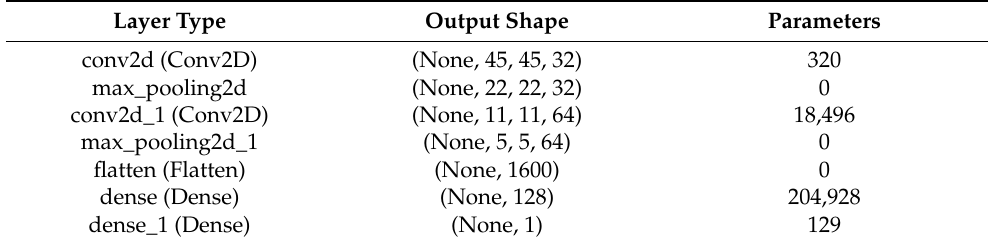
Table 1. The conventional base